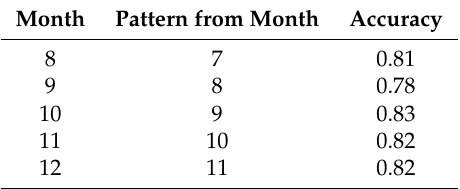
Table 1. Accuracy scores obtained applying patterns from month (t − 1) to month